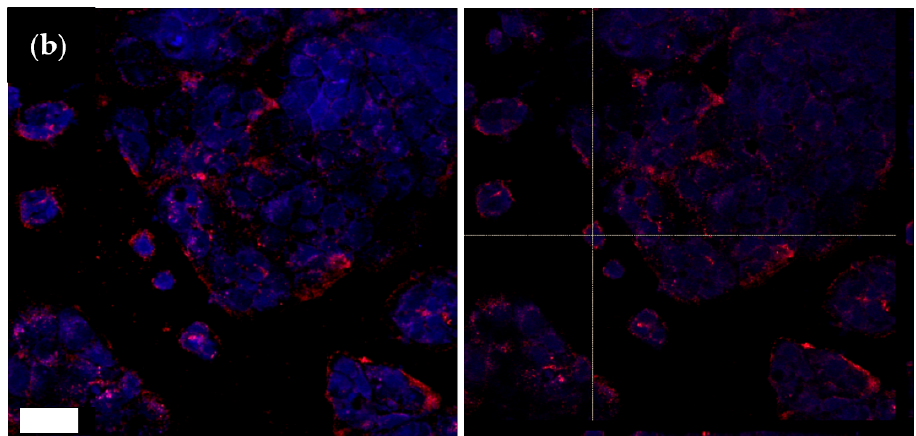
Figure 9. CLSM image ( left ) and z-projections ( right ) of Caco-2 cells after 24 h exposure to Nile red loaded NPs not functionalized ( a ) and functionalized with ICG ( b ) by adsorption at 0.4:1 ICG:CS ratio (ads-ICG NPs). Bar = 50 µm.